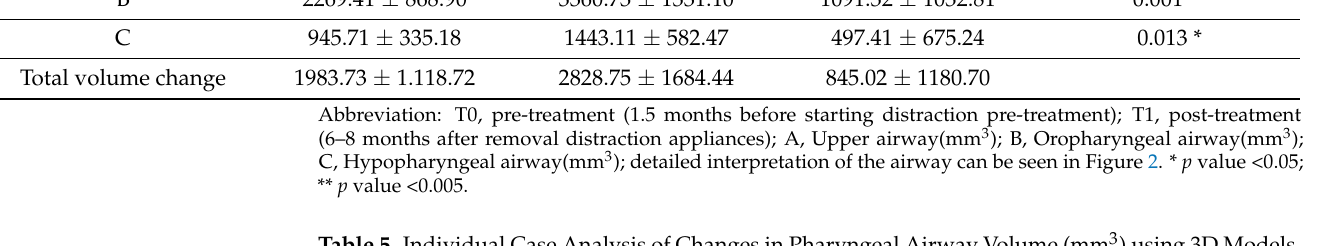
Table 5. Individual Case Analysis of Changes in Pharyngeal Airway Volume (mm 3 ) using 3D